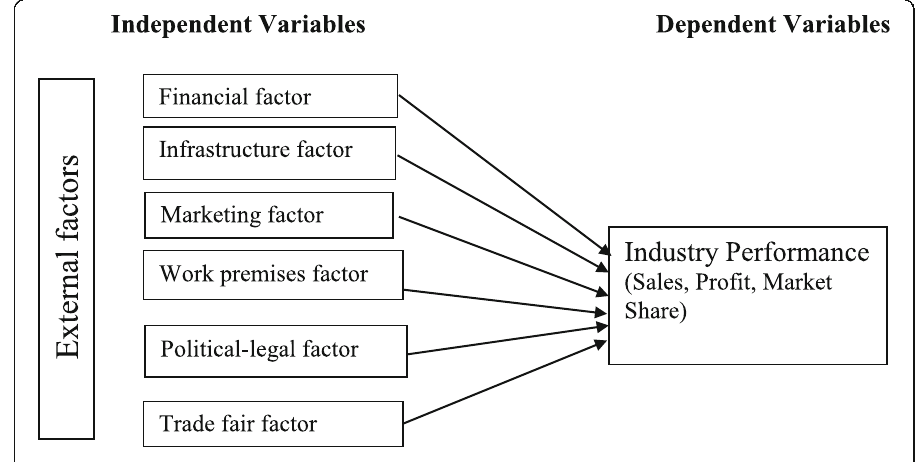
Fig. 1 Conceptual framework. Source: adopt from Admasu